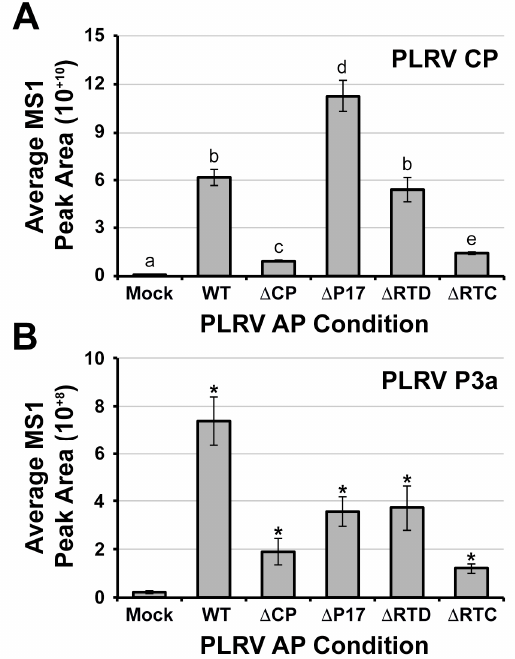
Figure 1. Label-free quantification of PLRV coat protein domain (CP) and P3a in α -PLRV affinity purifications (AP) from leaf tissue infected with WT or PLRV mutants. Bar graphs show the average relative protein abundance of ( A ) CP and ( B ) P3a quantified from the integration of MS1 (precursor ion) peak areas (unit-less) for protein specific peptides detected in AP samples from each of the PLRV infection conditions ( n = 6 analytical replicates representing three biological replicates). The level of background noise in mock-infected tissue is shown. The number of peptides used for the quantification of protein abundance are CP = 10 and P3a = 2 (Supplemental Table S1). Error bars represent ± the average standard error. Lowercase letters represent significant differences ( p < 0.05) measured by ( A ) Kruskal-Wallis rank sum test followed by a Conover post-hoc pairwise multiple comparison, which was further adjusted by the Holm FWER method and ( B ) by two-tailed, Wilcoxon signed-rank sum test compared to the mock-infected control where * p < 0.05.